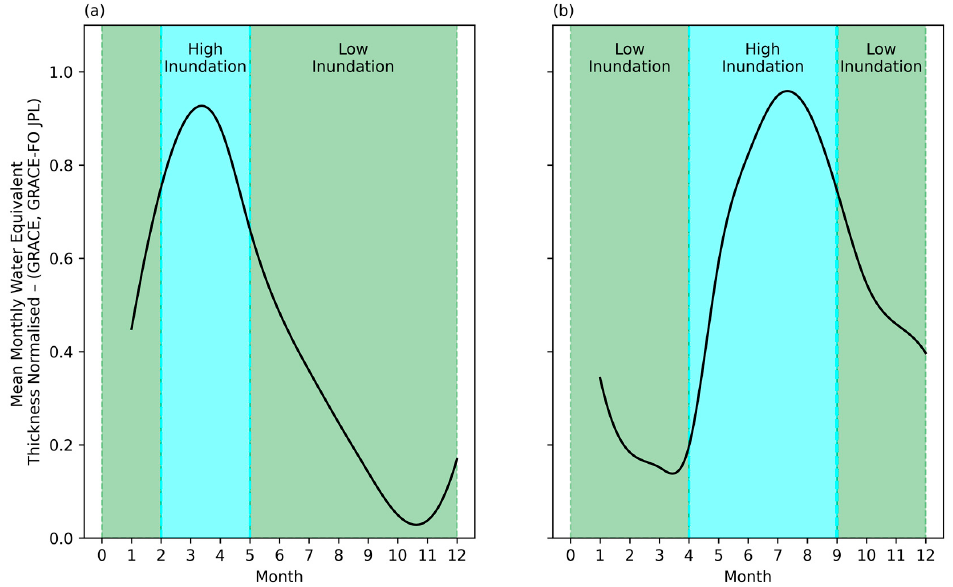
Figure 6. NASA GRACE and GRACE-FO (2000–2020) monthly crutinized gravity anomaly expressed as water equivalent thickness. ( a ) Monthly crutinized water equivalent thickness over the Barotseland Floodplain, with expected periods of high and low inundation timings defined by [5]. ( b ) Monthly crutinized water equivalent thickness over the North Rupununi Wetlands, with expected periods of high and low inundation timings de fi ned by [44,46].